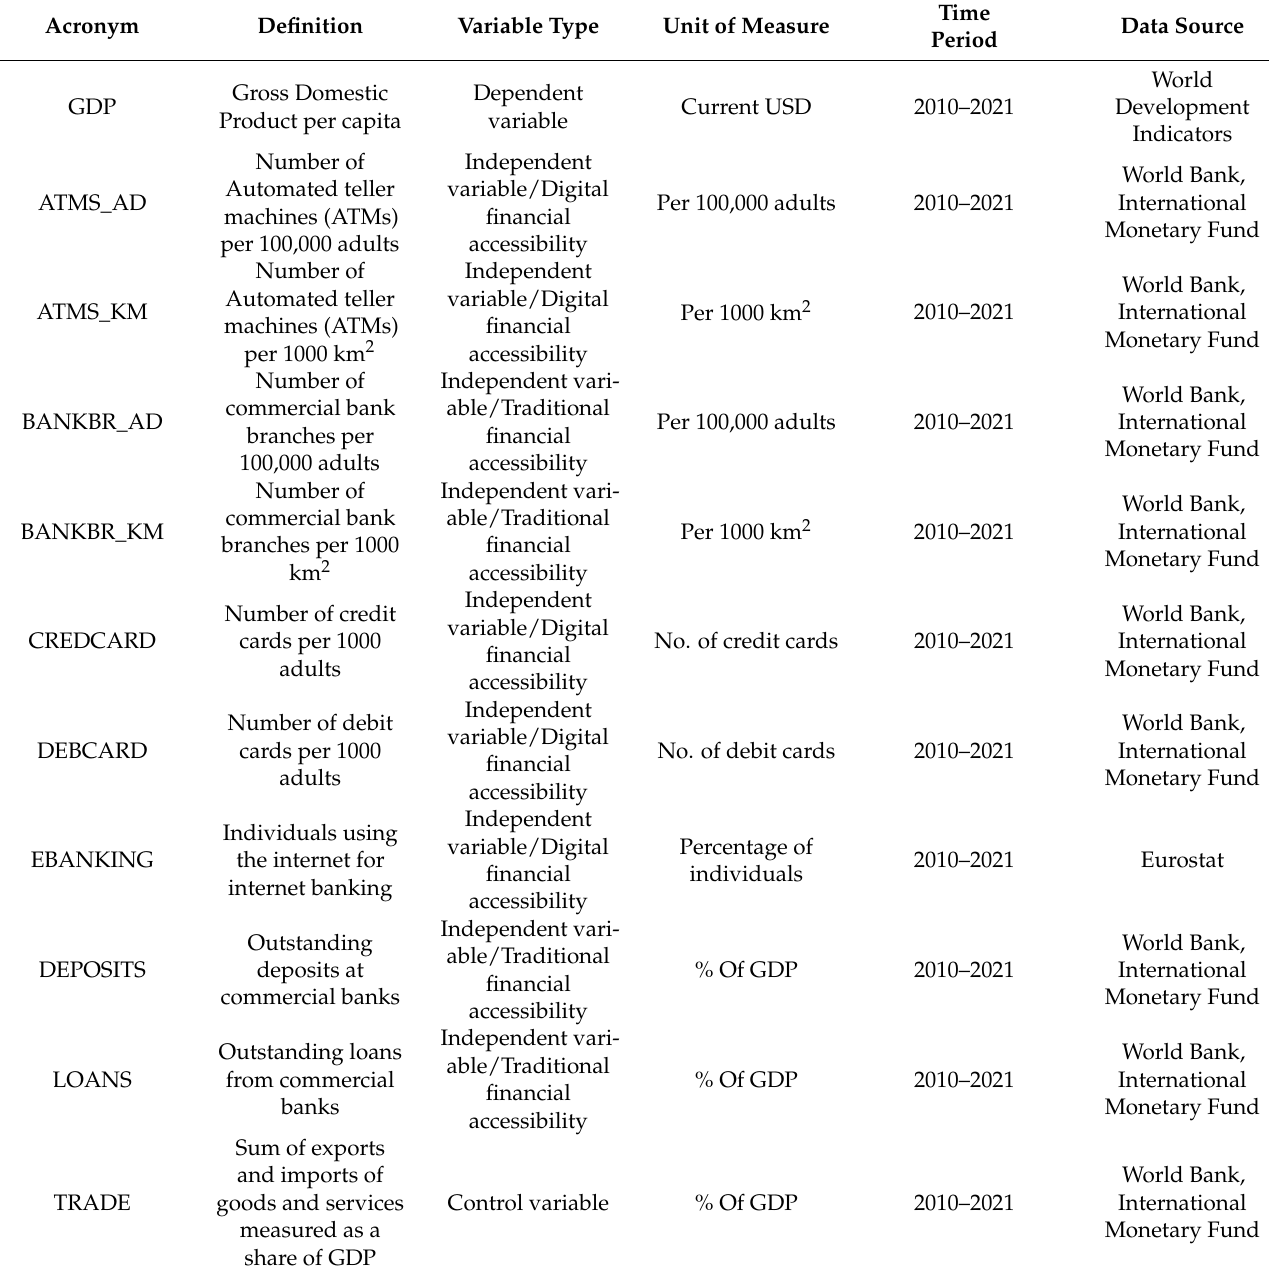
Table 1. Variables description and data